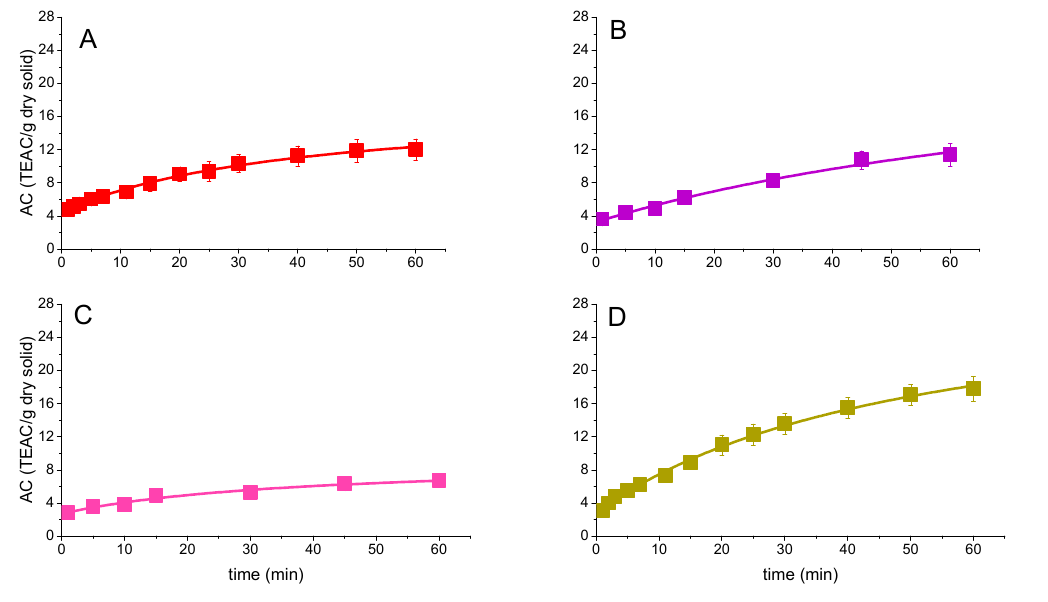
Figure 4. Kinetic analysis of the antioxidant activity as measured by the DPPH method during the extraction processes of AP employing a 70%/30% v/v ethanol/water mixture at several temperature values: ( A ) 25 °C, ( B ) 50 °C, ( C ) 70 °C, and ( D ) 90 °C. The lines show the fitting of a one-term second- order kinetic model (Equation (1)).